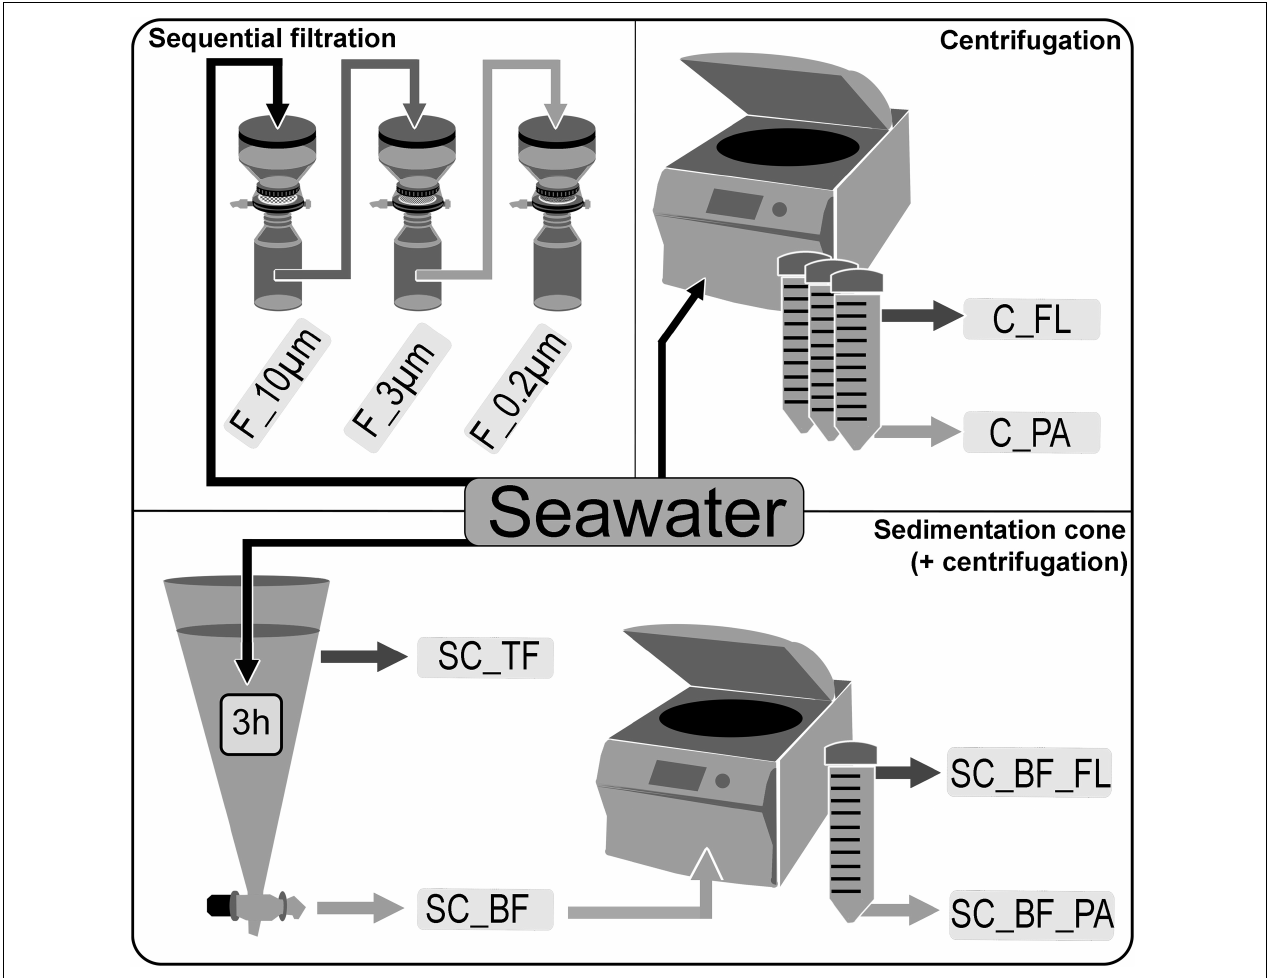
FIGURE 1 | Overview of separation methods to fractionate seawater during a phytoplankton spring bloom in 2018 off Helgoland (North Sea). Size-delimiting separation was performed by sequentially filtration through 10-, 3-, and 0.2- µ m filters (F_10 µ m, F_3 µ m, and F_0.2 µ m, respectively). Forced gravitational separation was achieved by centrifugation, resulting in a particle pellet (C_PA) and a supernatant with free-living cells (C_FL). Natural gravitational separation using Imhoff sedimentation cones used a 3-h settlement, resulting in a bottom fraction (SC_BF) and a top fraction (SC_TF). In a second separation, the bottom fraction (SC_BF) was divided by centrifugation into a supernatant with free-living cells (SC_BF_FL) and a pellet with particle-attached cells